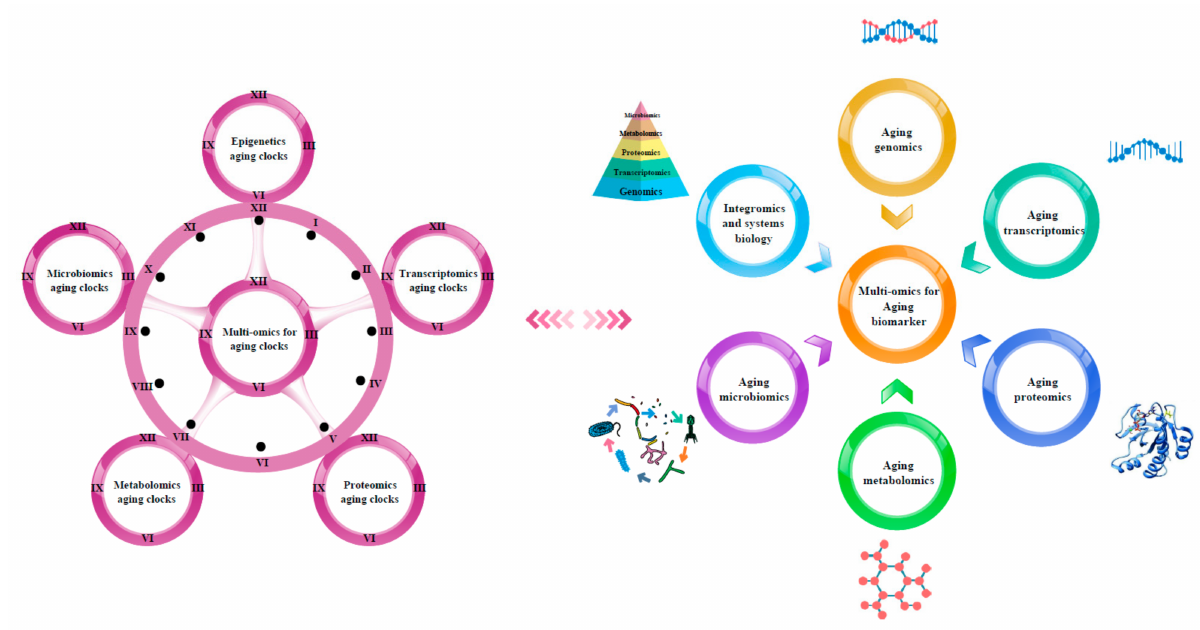
Figure 1. Multi-omics-based technologies for characterizing aging clocks and biomarkers. Aging is a comprehensive process affected by multiple factors that is associated with changes at the molecular, cellular, tissue, and organism levels, thus requiring objective analytical research tools. The inte- grated multi-omics approach is essential to achieve a comprehensive understanding of the biological mechanisms of